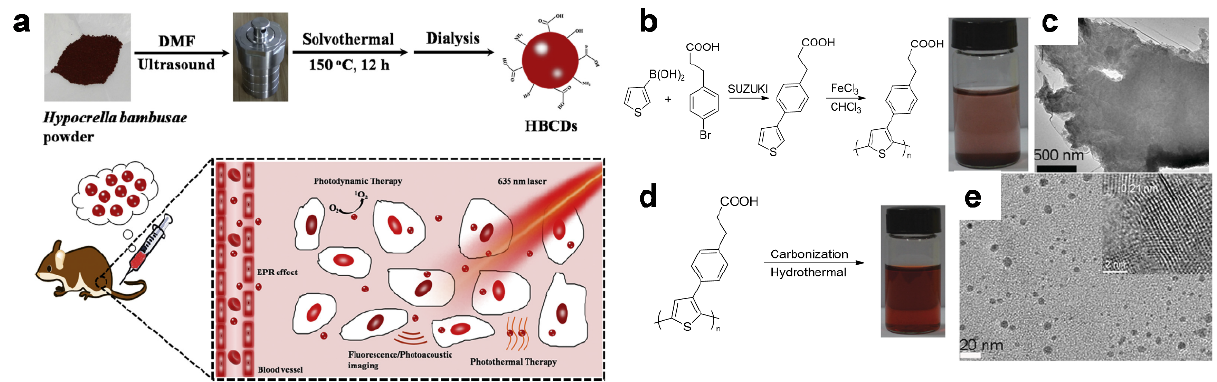
Figure 7. ( a ) Schematic illustration of HBCDs derived from Hypocrella bambusae (HB) for bimodal FL/PA imaging and synergistic PDT/PTT of cancer. Reprinted with permission from [81]. Copyright, Elsevier (2014). ( b – e ) Preparation and characterization of C-dots: ( b ) synthetic route to PPA (inset: the photograph shows that the PPA is insoluble in water). ( c ) TEM image of PPA. ( d ) synthetic route to C-dots (inset: the photograph shows water-dispersible C-dots). ( e ) TEM and high-resolution TEM (HRTEM) images of C-dots. Reproduced with permission from [82]. Copyright, John Wiley and Sons (2015).